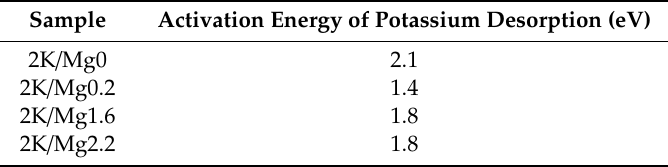
Table 3. Activation energies of K desorption for selected samples.